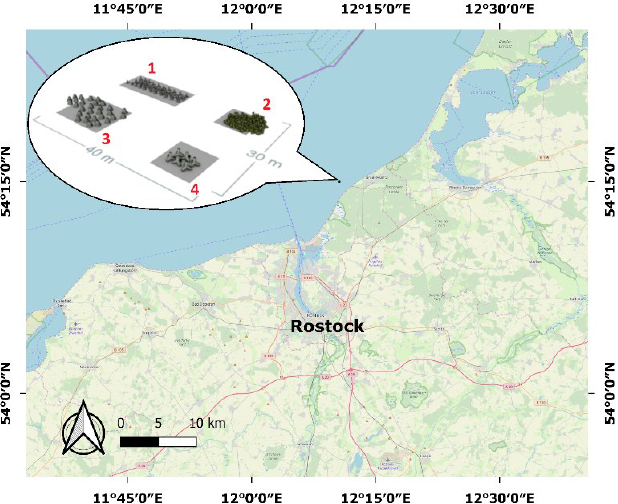
Figure 1. Location of the test area (approximately 25 km north of the city of Rostock in Germany).